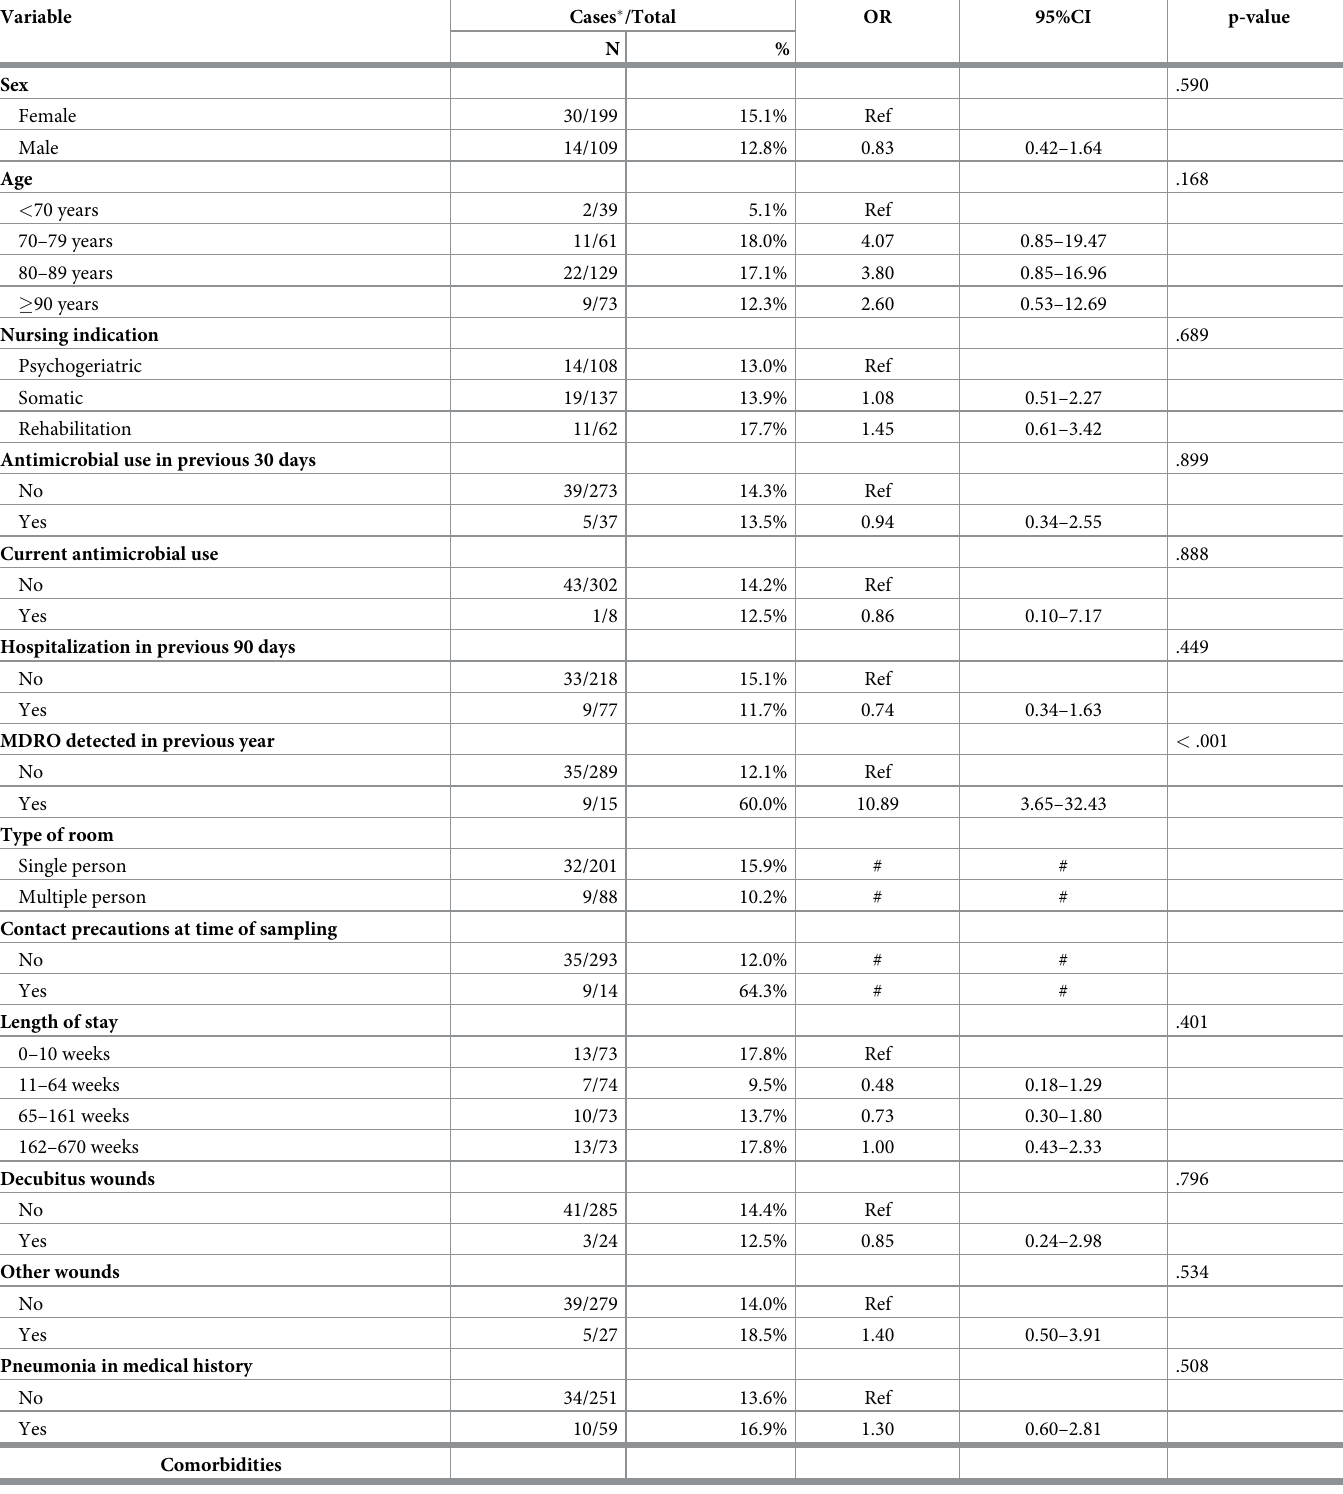
Table 2. Demographics and clinical characteristics of participating residents. Cases are ESBL-E carriers. Univariable associations of demographic and clinical charac- teristics with ESBL carriage of LTCF participants with both a fecal swab and questionnaire available for analysis (N =